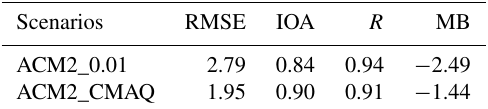
Table 4. Statistical performances of ACM2_0.01 and ACM2_CMAQ in simulating T2.